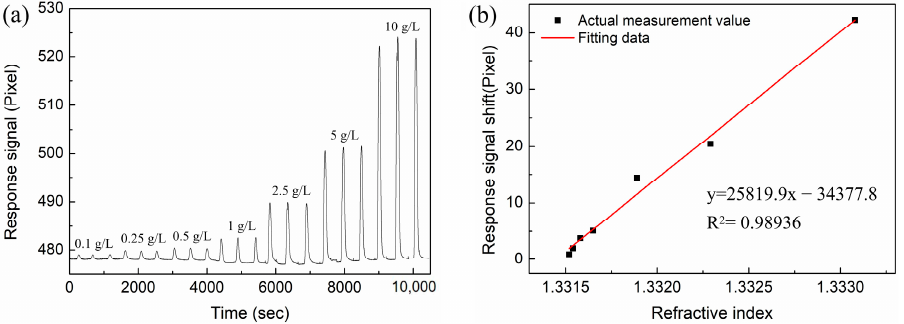
Figure 11. ( a ) The response curves of NaCl solution with different concentrations for the proposed biosensor based on four layers of MoS 2 . ( b ) The corresponding linear fitting line.